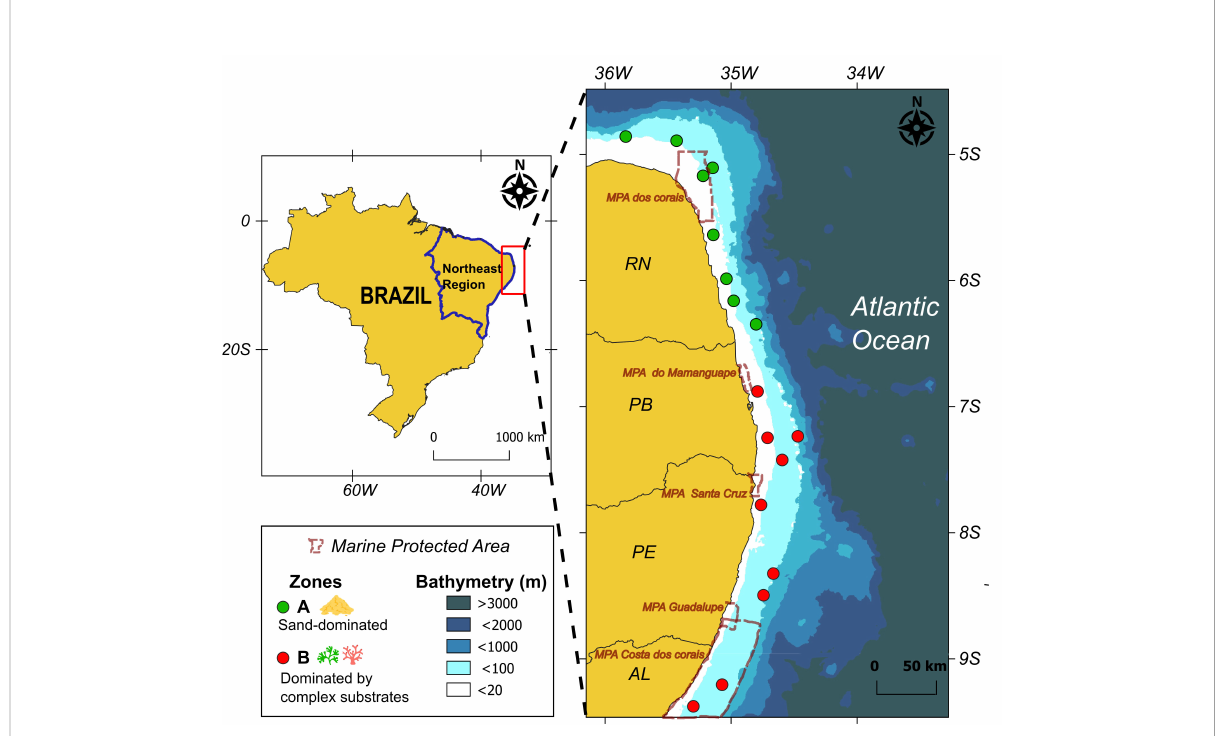
FIGURE 1 Study area with sampling points in northeastern Brazil, in two contrasting zones: one dominated by sand (green dots) and another with more complex substrates such as algae and coral reefs (red dots).AL, Alagoas; PB, Paraiba; PE, Pernambuco; RN, Rio Grande do